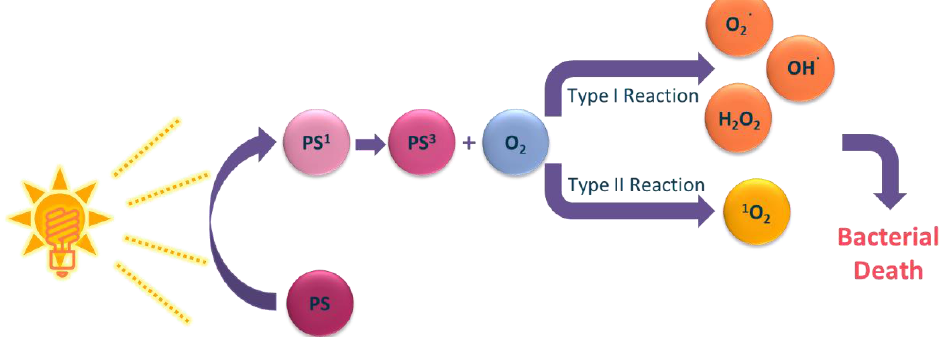
Figure 1. Schematic presentation of light-mediated cell damage during photodynamic treatment.